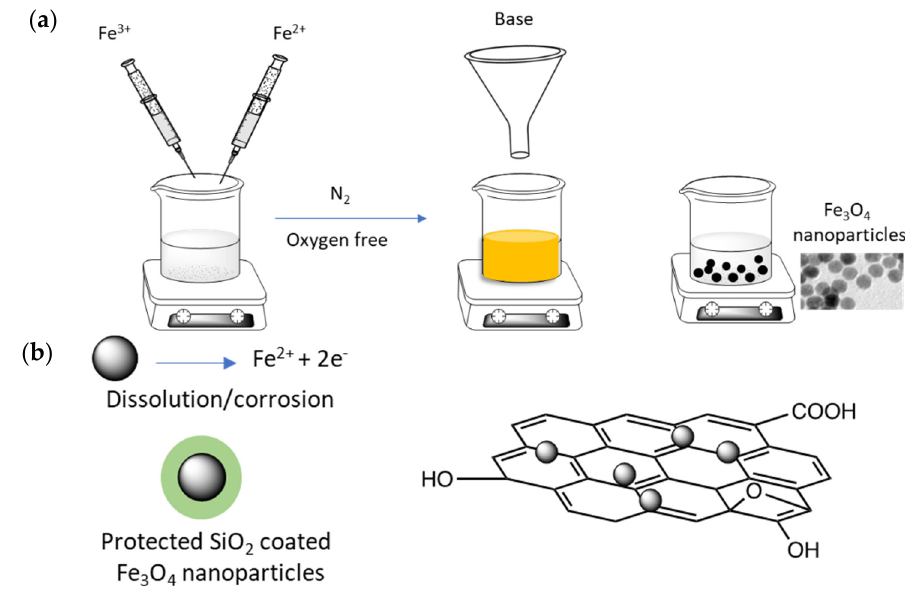
Figure 6. ( a ) Schematic representation of the co-precipitation method used to prepare Fe 3 O 4 ( b ) SiO 2 coated Fe 3 O 4 nanoparticles deposited and dispersed on GO.